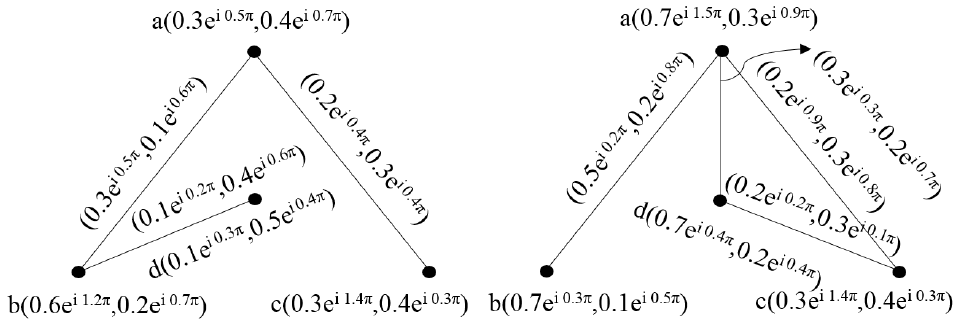
Figure 7. Complex intuitionistic fuzzy graphs of G 1 and G 2 .